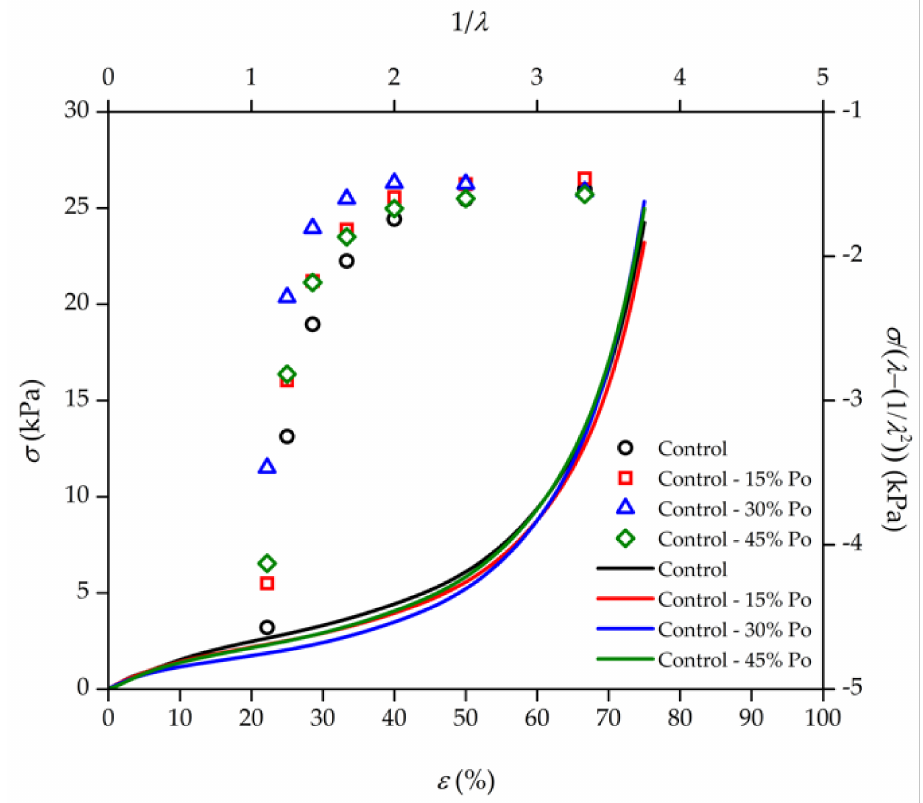
Figure 3. Results of the mechanical properties of rubber foam in two forms: (i) stress ( σ )–strain ( ε ) curves of foam samples with various concentrations of chemical blowing agent in lines; (ii) the Mooney–Rivlin equation [17] for rubber foam in the unfilled symbols. The relative scatter on the results is estimated to be about